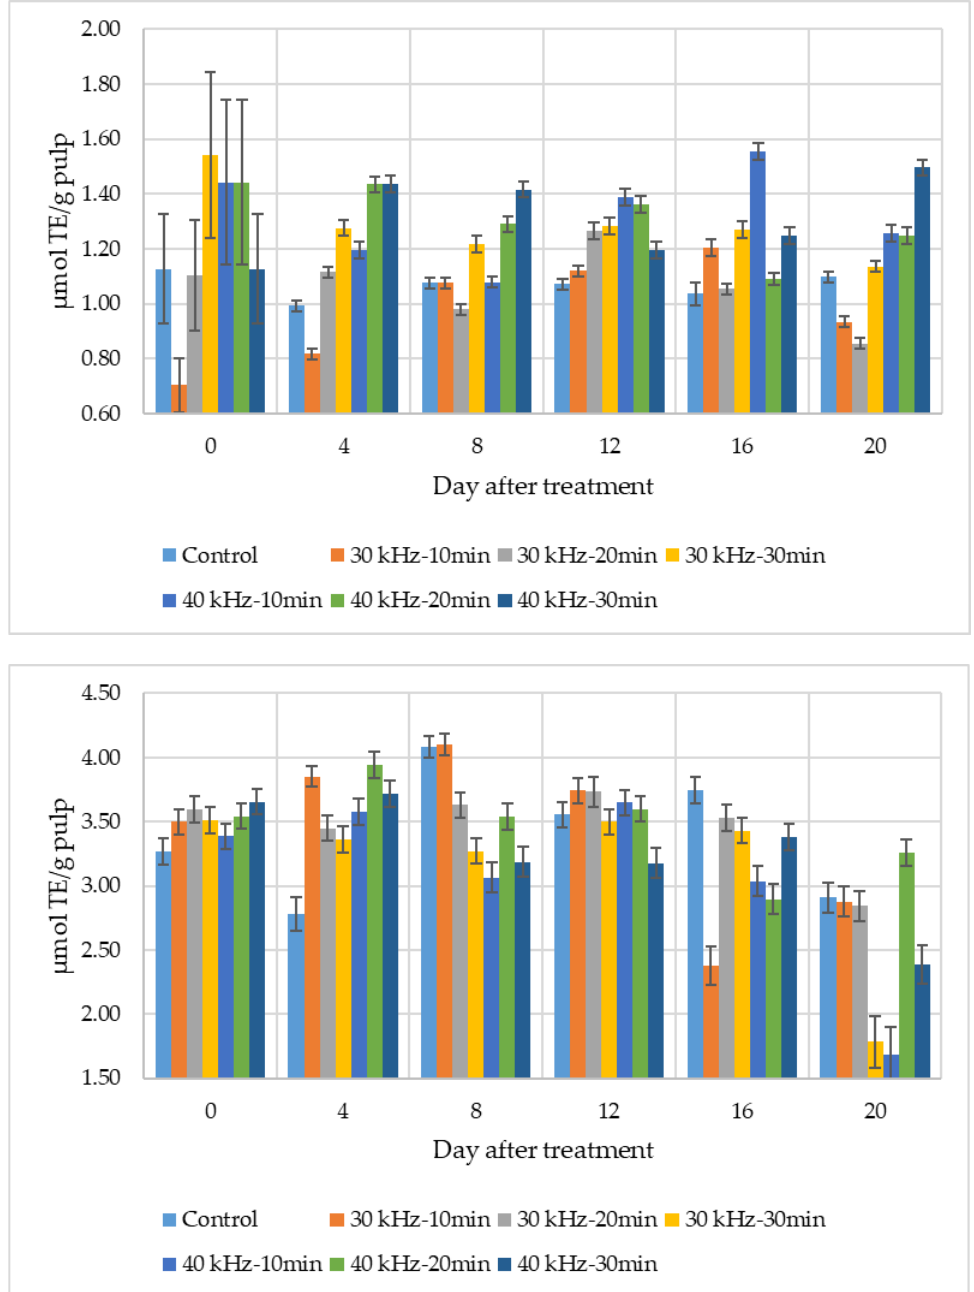
Figure 1. Changes in Trolox-Equivalent Antioxidant Capacity (TEAC) measured as ABTS •+ (2,2’ - azino-bis(3-ethylbenzothiazoline-6-sulfonic acid) Cationic Radical Assay ( Top ) and DPPH· (2,2- diphenyl-1-picrilhydrazil) Radical Scavenging Assay ( Bottom ) during storage at 4 °C in Passiflora edulis f. edulis Sims pulp ( gulupa ) subjected to low-frequency ultrasound treatments. Data expressed as mean ± standard deviation of three repetitions.